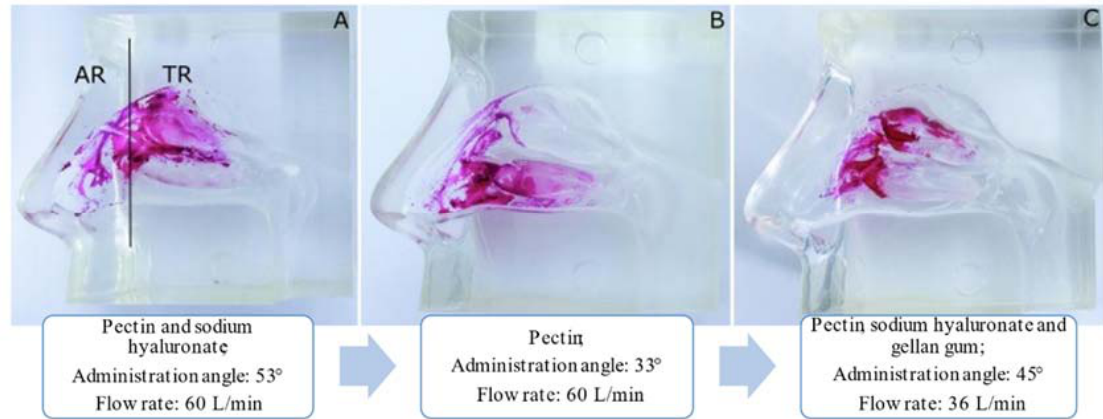
Figure 4. Evaluation of the deposition of fluticasone in situ gels in a 3D nasal cast covered with Sar-gel. ( A ) in situ gels of pectin and sodium hyaluronate, with an administration angle of 53° and a flow rate of 60 L/min; ( B ) in situ gel of pectin, with an administration angle of 33° and a flow rate of 60 L/min, ( C ) in situ gel of pectin, sodium hyaluronate and gellan gum, with an administration angle of 45° and a flow rate of 36 L/min (adapted from [70], with permission from Elsevier).